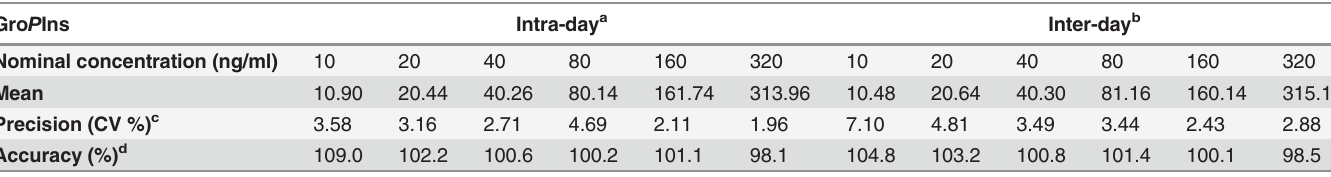
Table 2. Intra-day and inter-day precision and accuracy in Raw 264.7 cell